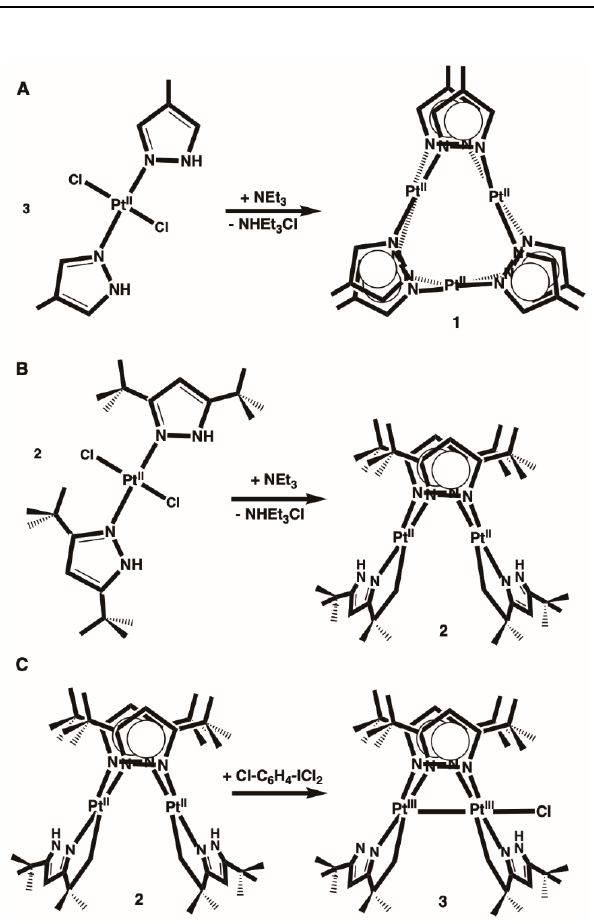
Table 1. Selected experimental and calculated distances (Å) and angles (°) for 1 , 2, and 3 , calculated data in